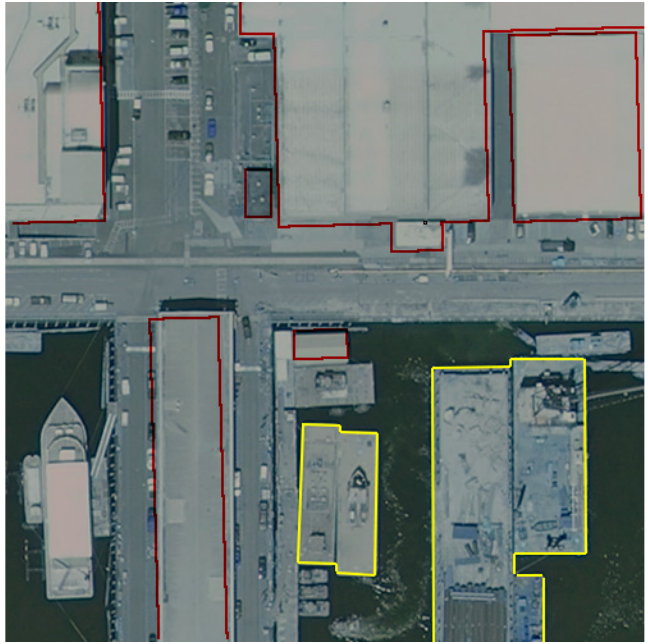
Figure 12. Aerial image with marked building footprints from cadaster (red) and moored vessels (yellow).